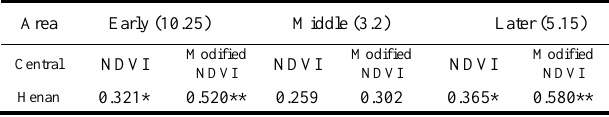
Table 3. Correlations of NDVI, modified NDVI and soil